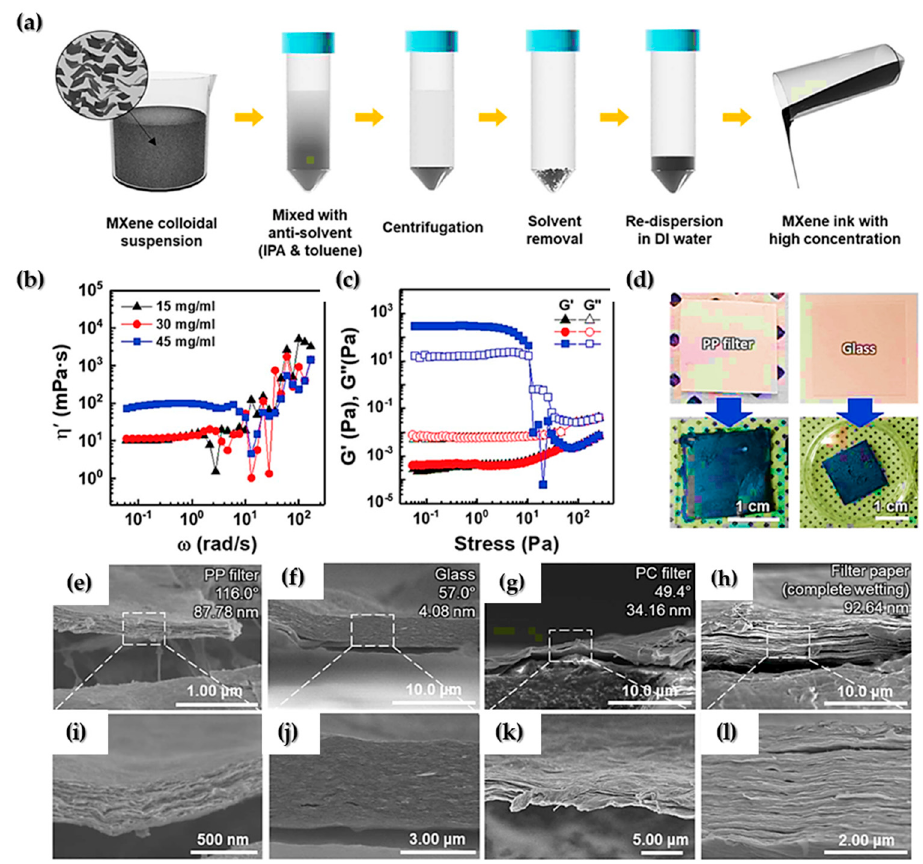
Figure 2. ( a ) Schematic illustration of the fabrication process of MXene ink. ( b ) Dynamic shear viscosity ( ɳ ’) curves of MXene inks at various concentrations and ( c ) the storage ( G’ ) and loss ( G’’ ) moduli curves of MXene inks as a function of shear stress at different flake concentrations. ( d ) Painted MXene ink on various substrates using a brush. SEM cross − sectional images of painted MXene ink on the ( e , i ) PP filter, ( f , j ) glass, ( g , k ) PC filter, and ( h , l ) filter paper. Detailed information (i.e., contact angle and root − mean − square surface roughness) on the bare substrates is included on the upper right in ( e – h ), reprinted with permission from [62].